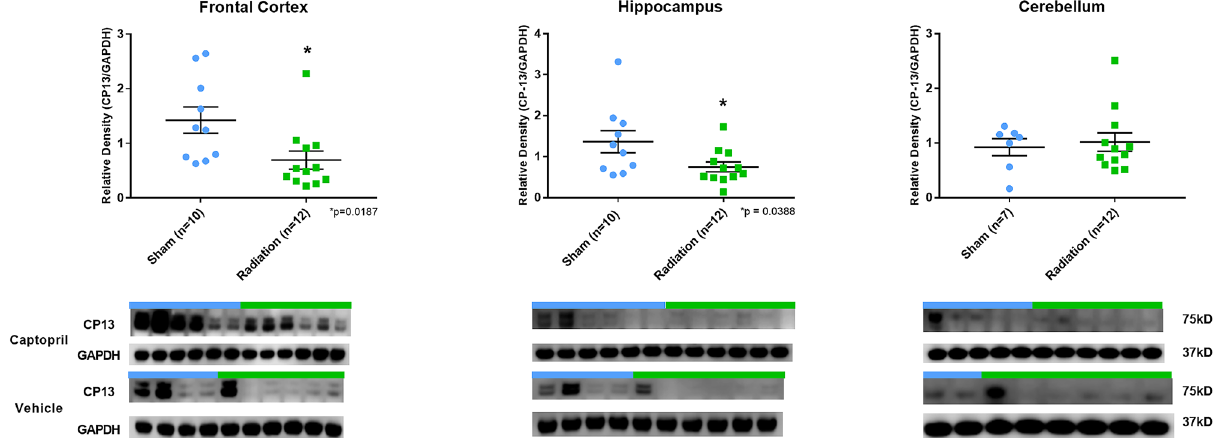
Figure 1. Phosphorylated-Tau expression in brain following total body radiation. Histograms representing the densitometric ratio of levels of pTau (CP13) with respect to GAPDH as measured in the frontal cortex, hippocampus and cerebellum in the brains of Gottingen mini-pigs 30-days after total body radiation (1.79 Gy of Cobalt [ 60 Co]) with representative western blots # for sham and radiation exposed animals treated with captopril or vehicle. There was no statistical difference between captopril or vehicle treated groups, so data was pooled for each group represented in histograms above. *indicates p values < 0.05 as determined by 2-tailed, unpaired, t-tests. Error bars represent standard error of the mean (SEM). # for full length blots for each antibody, see Supplementary Fig.